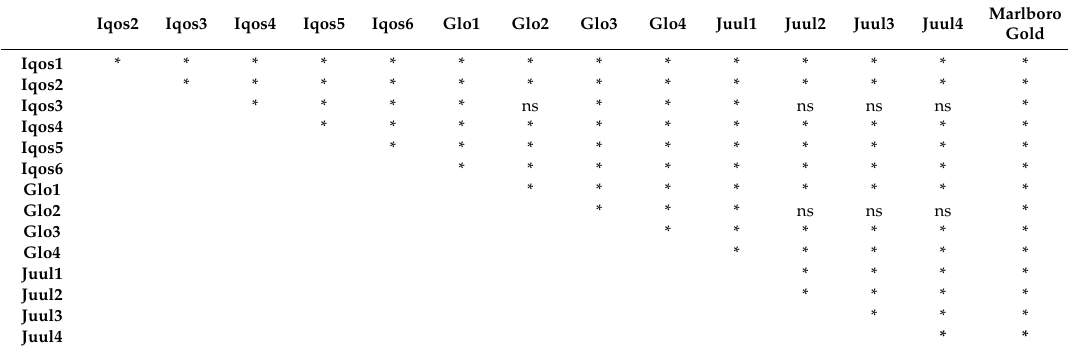
Table 3. Pairwise post hoc tests between the levels of PM with an aerodynamic diameter smaller than 1 µm (PM 1 ; µg m − 3 ) measured in each experiment.